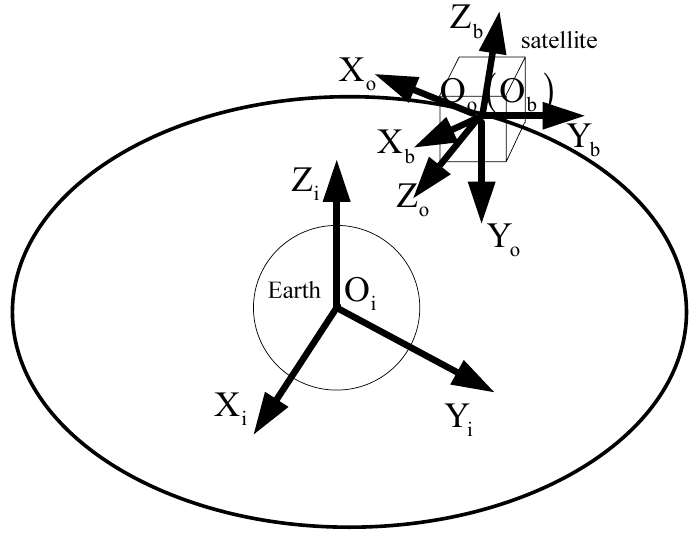
Figure 1. The relationship between the coordinate